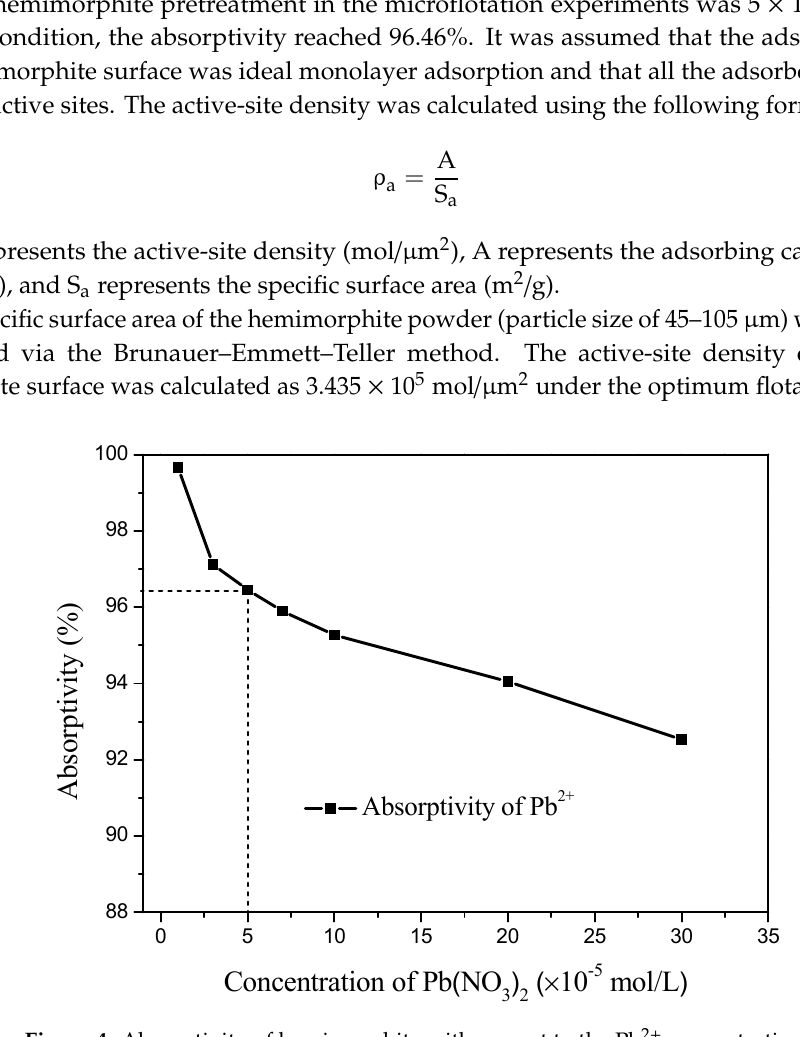
Figure 4. Absorptivity of hemimorphite with respect to the Pb 2+ concentration.